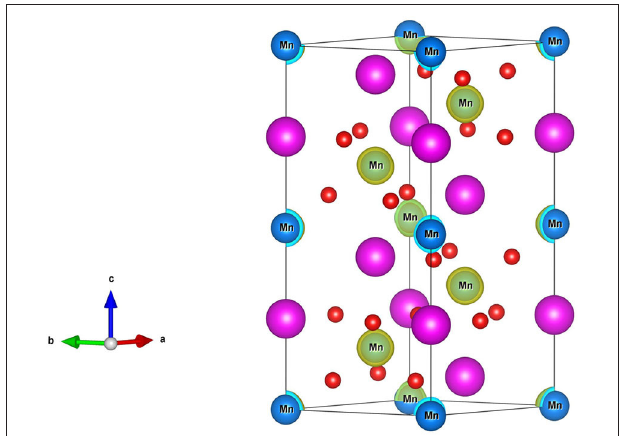
FIGURE 2 | Spin-density of GdMnO 3 obtained by the DFT + U